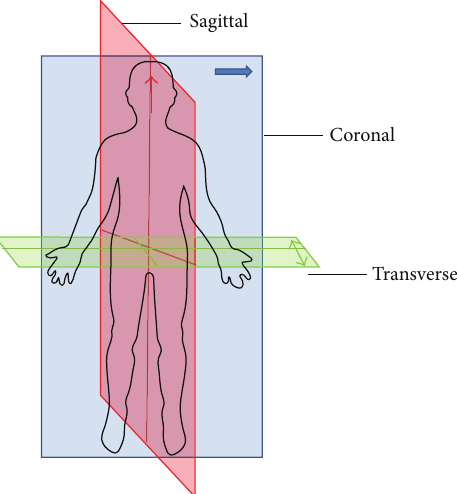
Figure 1: Anatomical planes of the